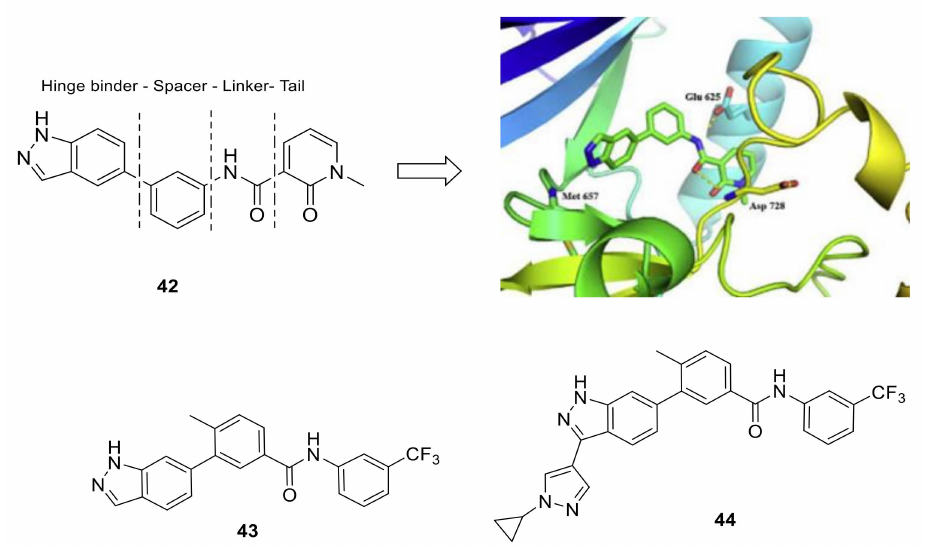
Figure 18. Chemical structures of compounds 42 – 44 and docking model of compound 42 into DDR2 active site. Reprinted with permission from Ref. [150].